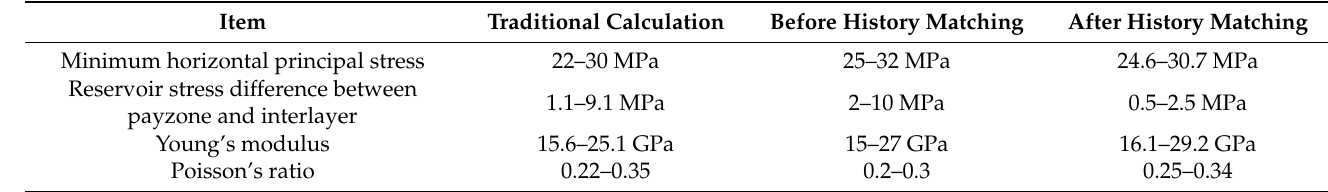
Table 1. Comparison of geomechanical parameters before and after calibration.